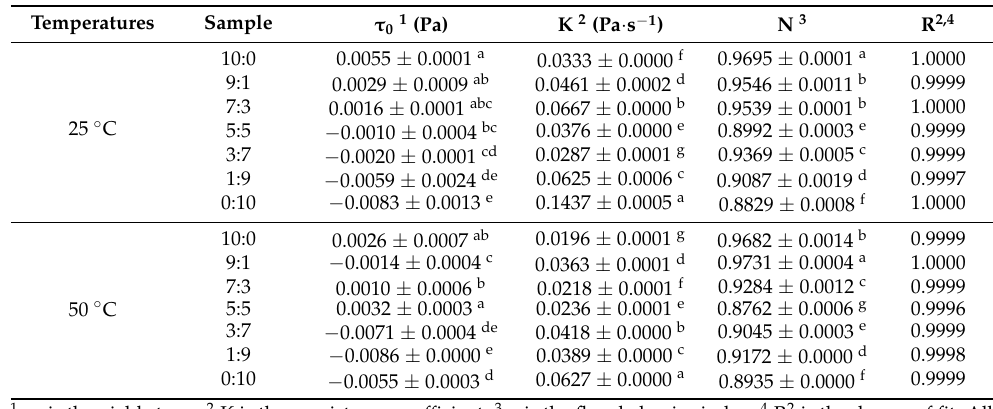
Figure 3. Shear rheological curve of sodium caseinate-acetylated mung bean starch–lutein emulsion. 10:0, 9:1, 7:3, 5:5, 3:7, 1:9, and 0:10, respectively, represent the weight ratio of sodium caseinate and acetylated mung bean starch. Table 1. Fitting parameters of Herschel–Bulkley equation for sodium caseinate-acetylated mung bean starch–lutein emulsion.